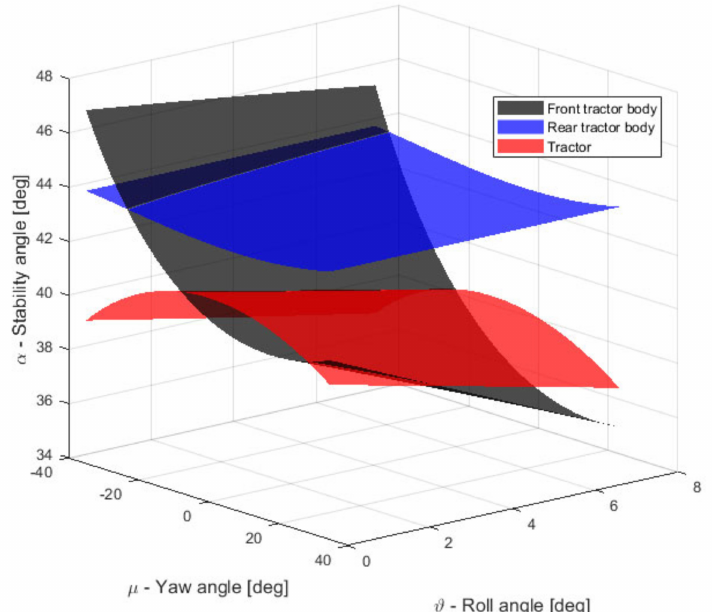
Figure 7. The stability angles of the separate bodies and the whole tractor vs. Yaw angle and Roll angle. Front body (black surface), the rear body (blue surface) and the whole tractor (red